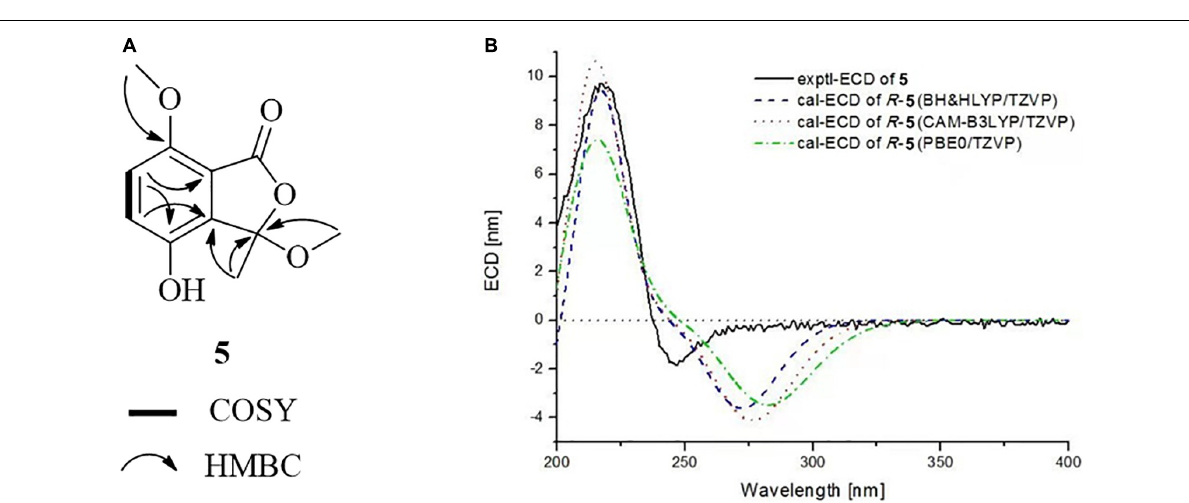
Frontiers in Microbiology |